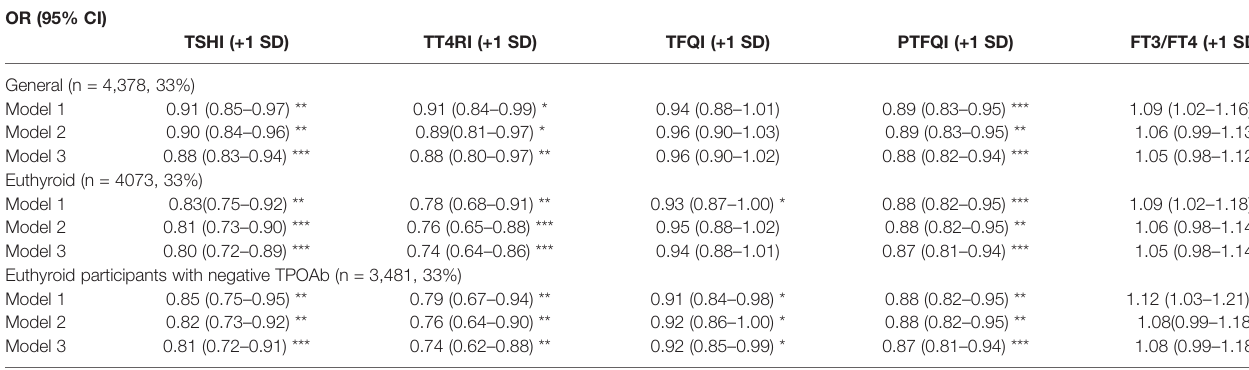
TABLE 2 | Association between indices of thyroid hormone sensitivity and prevalence of prediabetes. OR (95% CI)